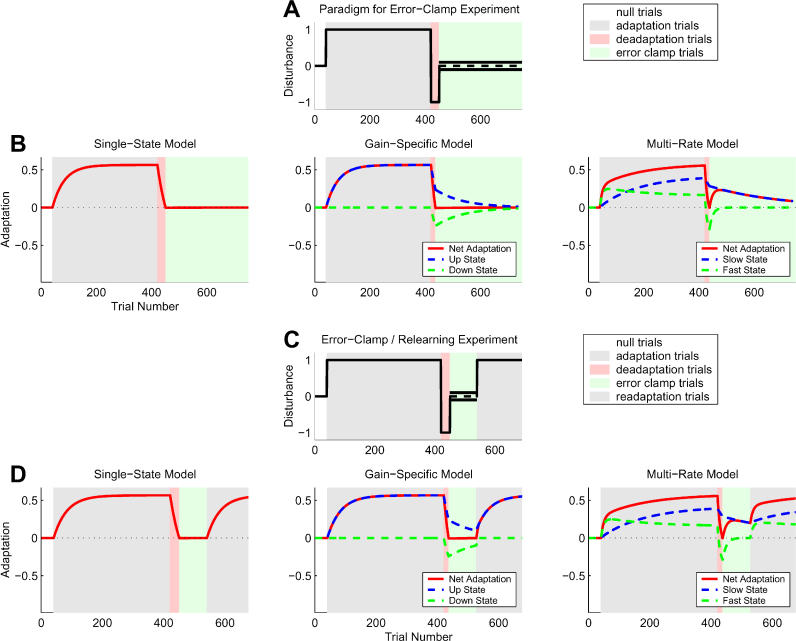
Simulations of Motor Adaptation in the Error-Clamp Paradigm(A) Paradigm for simulated error-clamp experiment. This paradigm is similar to the savings paradigm shown in
Figure 1A except that the relearning block is replaced by an error-clamp block during which the error that drives adaptation is held at zero.
(B) Model simulations of the experiment paradigm shown in (A). The different columns display simulation results form the single-state, gain-specific, and multi-rate models, respectively. The single-state and gain-specific models do not predict changes in motor output from baseline in the error-clamp block, whereas the multi-rate model predicts a transient rebound of motor output in the error-clamp block. This rebound is in the direction of the motor output displayed in the initial learning block, resulting in spontaneous recovery.(C) Paradigm for the error-clamp/relearning experiment. Here a relearning block follows a shortened error-clamp block. This paradigm reproduces the effect of jump-up facilitation seen by Kojima et al. following dark exposure. During dark exposure, monkeys made saccades but received no visual feedback of saccade error. The absence of error feedback may be similar to the zero-error condition produced by the error-clamp.(D) Model simulations of the experiment paradigm shown in (C). The columns are the same as in (B). The multi-rate model predicts that performance at the start of the relearning block is already better than baseline. This jump-up in performance is caused by adaptation rebound in the error-clamp phase. Kojima et al. showed that following a period of dark exposure (during which saccade gain was not measured) monkeys displayed an immediate jump-up in performance at the start of the subsequent relearning block. This finding is predicted by the multi-rate model, but is not predicted by the single-state or gain-specific models.